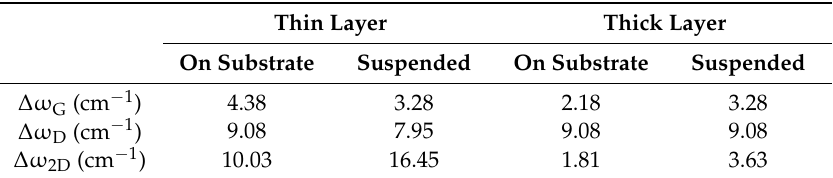
Table 2. The frequency upshifts of the Raman G ( ∆ ω G ), D ( ∆ ω D ), and 2D ( ∆ ω 2D ) bands of graphene sheet with different locations after annealing at 500 ◦